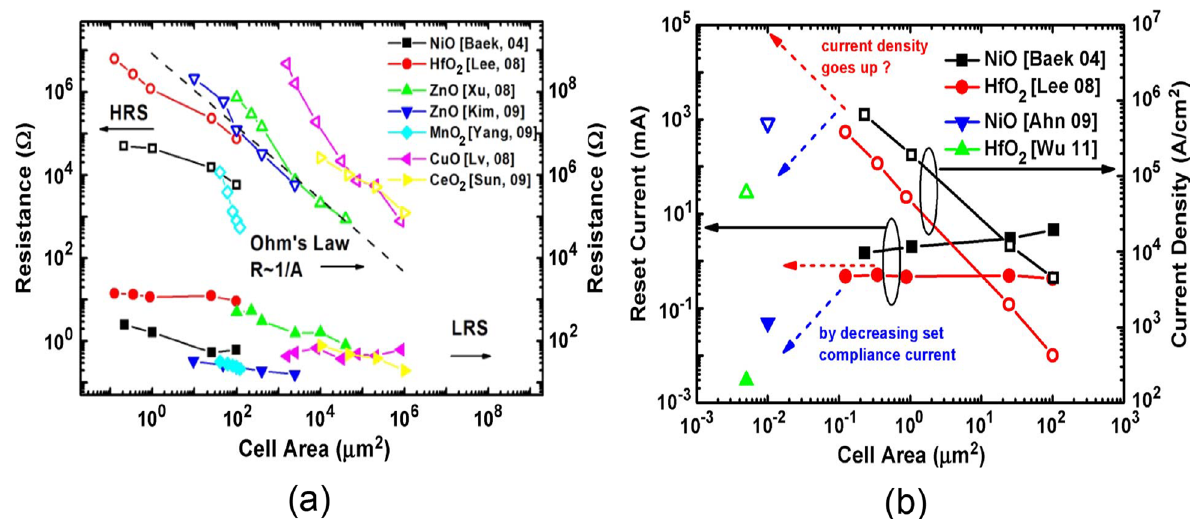
Fig. 11 a HRS and LRS resistance vs cell area. b The peak value of reset current and corresponding current density versus cell area. Repro- duced with permission from [84] Copyright